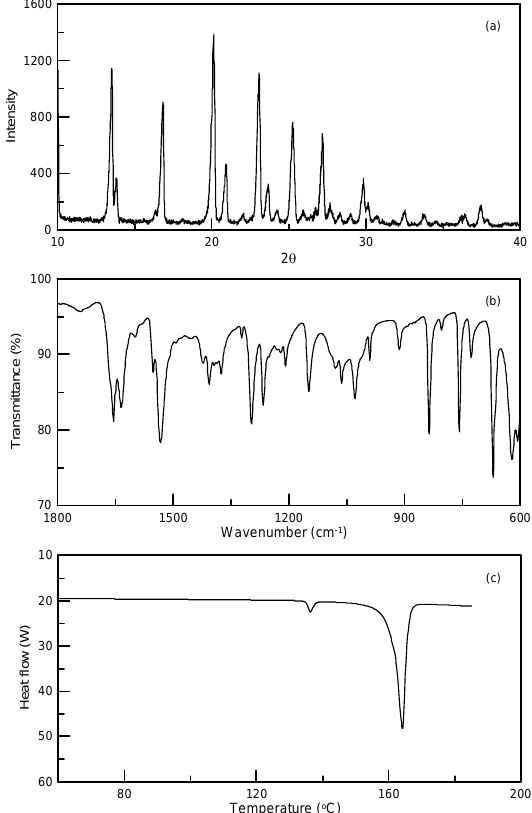
Figure 8. Analytical results of the following methods for the synthesized N ′ -(propan-2-ylidene)-isonicotinohydrazide crystals obtained after conducting Experiment 8: ( a ) PXRD; ( b ) FTIR; and ( c ) DSC.